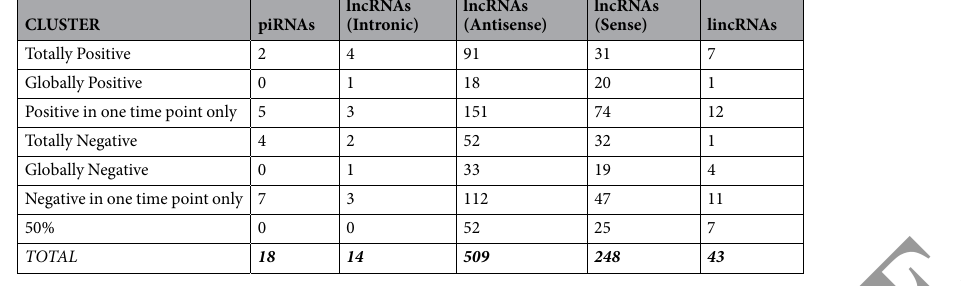
Table 2. Cluster analysis of ncRNAs without repetitive values of fold change. All significant differentially expressed ncRNAs with no repetitive fold change were clustered by the presence of increased FCs in more than two times points and no fold change reduction (“totally positive”), increased FCs in a single time point (“positive in 1 time point only”) or with a prevalence of raised FCs over decreased ones (“globally positive”) throughout all analyzed time points. The same approach was, then, considered for down–regulated ncRNAs (“totally negative”, “globally negative” and “negative in 1 time point only”). A final cluster was, then, created based on a perfect balance between up–regulated and down–regulated time points (“50%”).